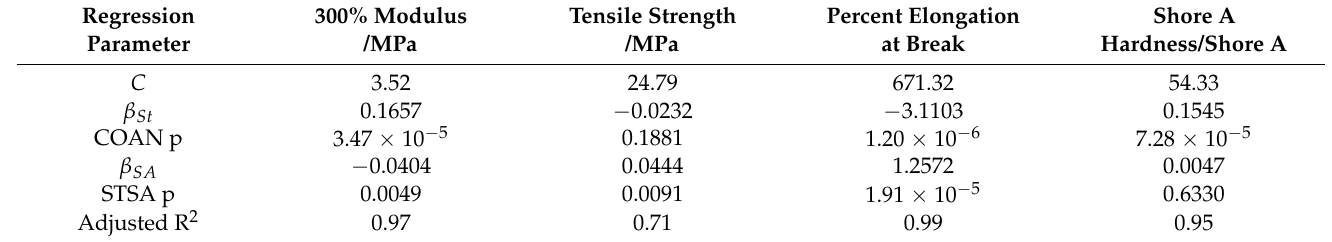
Table 4. Results of multiple linear regression analysis of tensile properties–CB colloidal